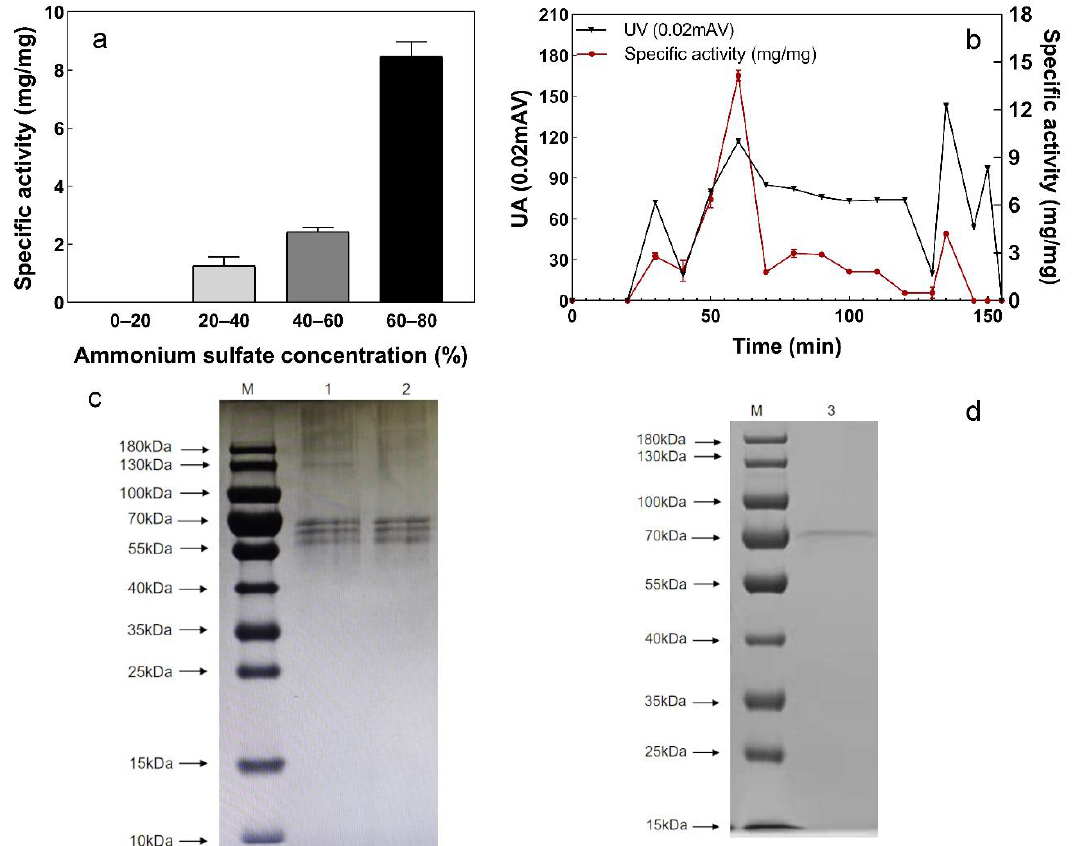
Figure 5. Purification of sulfur convertase, ( a ) specific activity of precipitated enzymes at different ammonium sulfate concentrations, ( b ) precipitation time and specific activity of each protein; specific activity: the amount of sulfide (mg) converted per mg of protein for 24 h, ( c , d ) the SDS-PAGE images of strain L1, CS, and sulfur convertase M: protein marker; 1: strain L1; 2: CS; 3: sulfur convertase. Table 2. Steps of the purification of sulfur convertase.